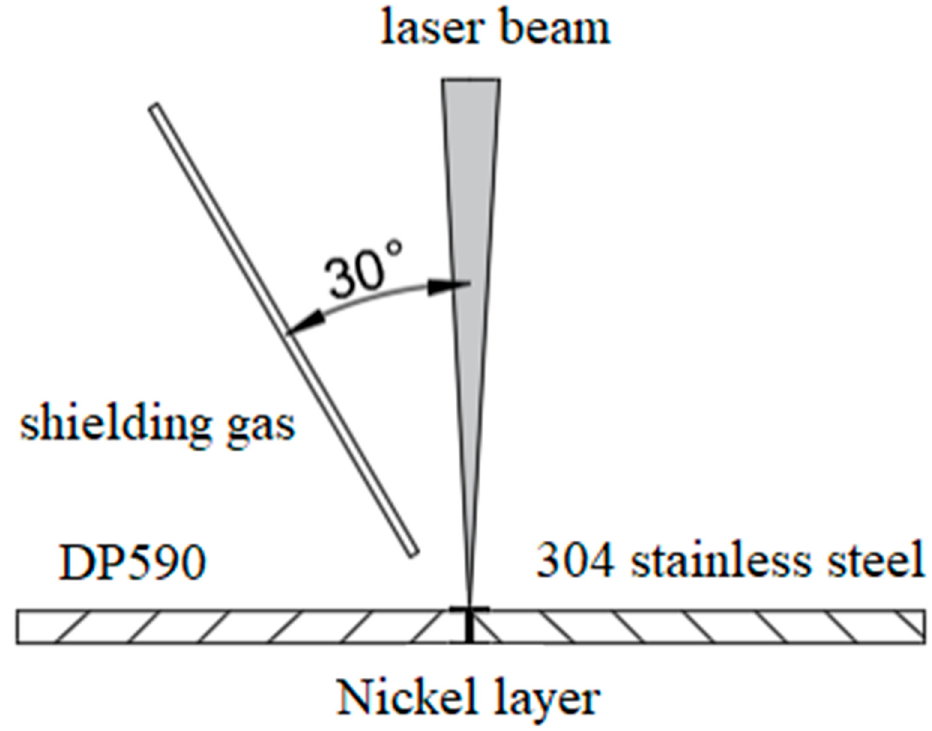
Figure 1. Schematic diagram of laser welding.